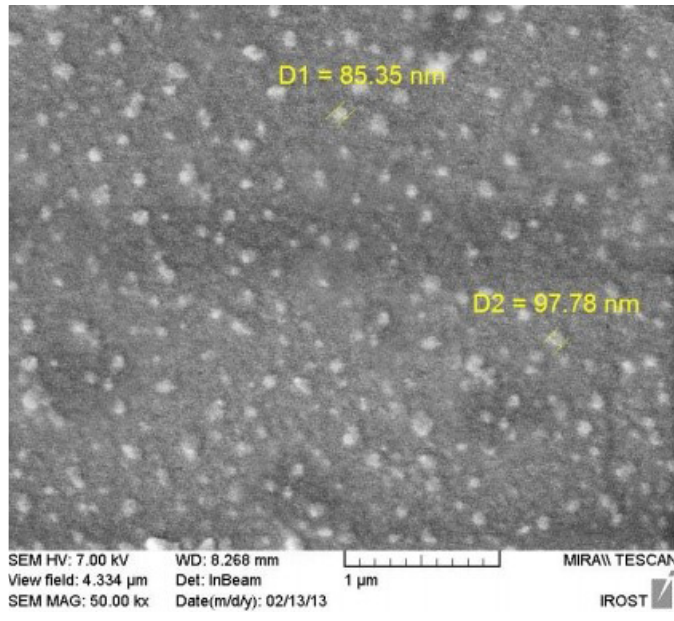
Fig. 6. SEM image of the mesalamine loaded chitosan